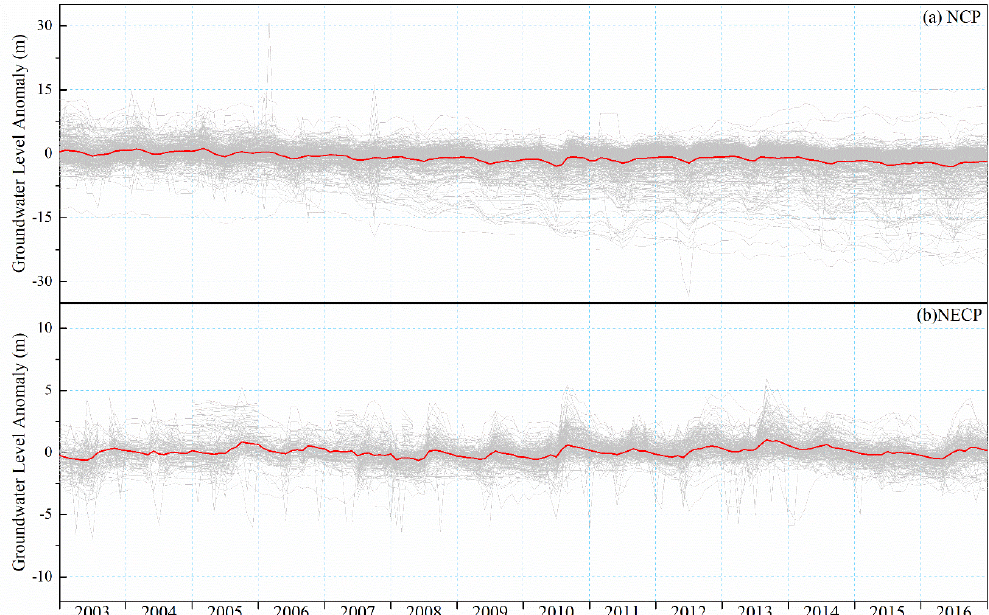
Figure 5. Monthly time series of observed GWLA from 2003 to 2016.